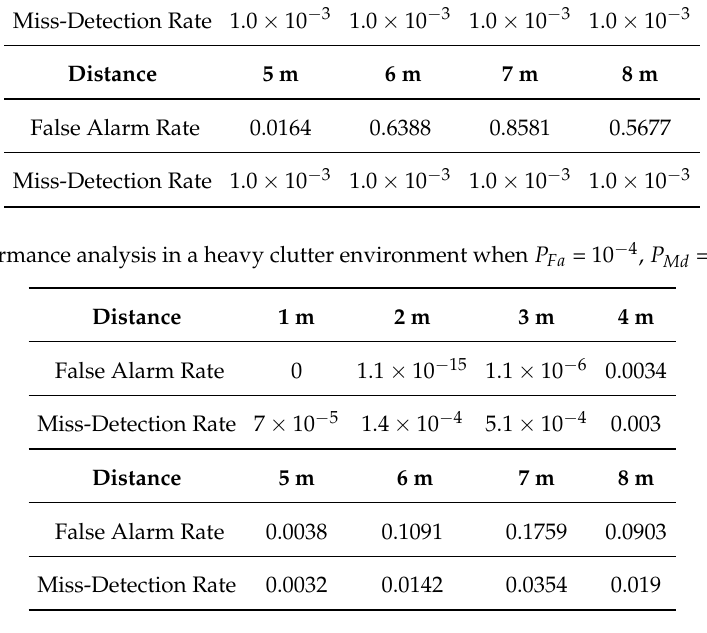
Table 8. Performance analysis in a heavy clutter environment when P Fa = 10 − 4 , P Md = 10 − 3 , α =